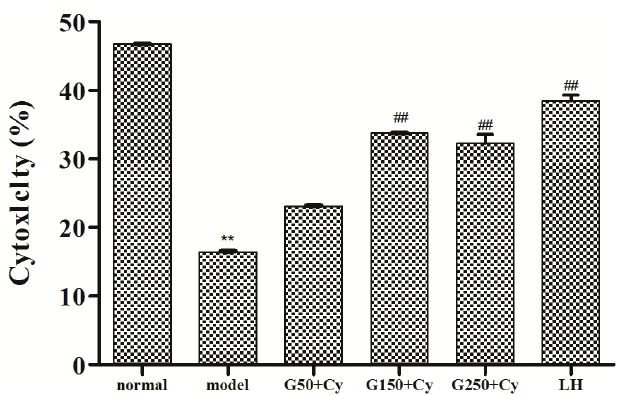
Figure 5. Effect of GPMPP on cytotoxicity of natural killer cells in Cy-treated mice. ** p < 0.01, compared with normal control. ## p < 0.01, compared with model control. Values are means ± SD, n = 10.